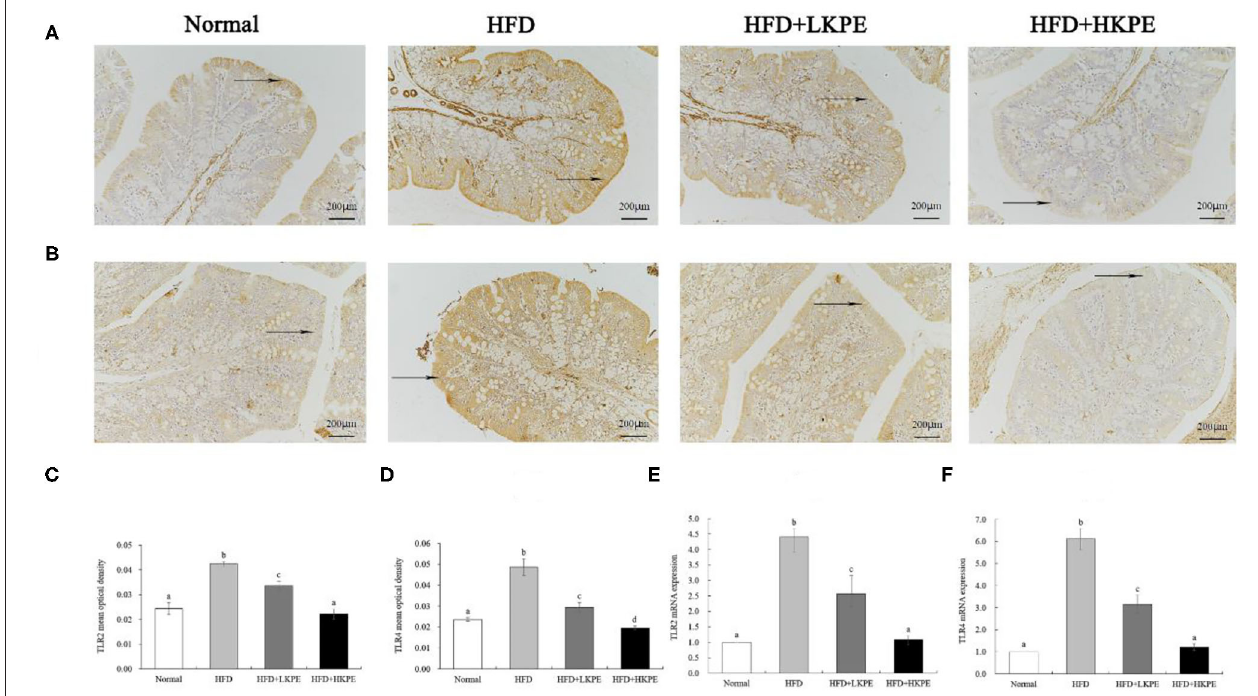
FIGURE 5 | KPE supplementation decreases the expression of TLR-2 and TLR-4. (A) Immunohistochemical images of TLR-2; (B) Immunohistochemical images of TLR-4; (C) Mean optical density of TLR-2; (D) Mean optical density of TLR-4; (E) The mRNA expression levels of TLR-2; (F) The mRNA expression levels of TLR-4. Different letters (a–d) are used to express the significant difference ( P < 0.05) of the same factor among groups.